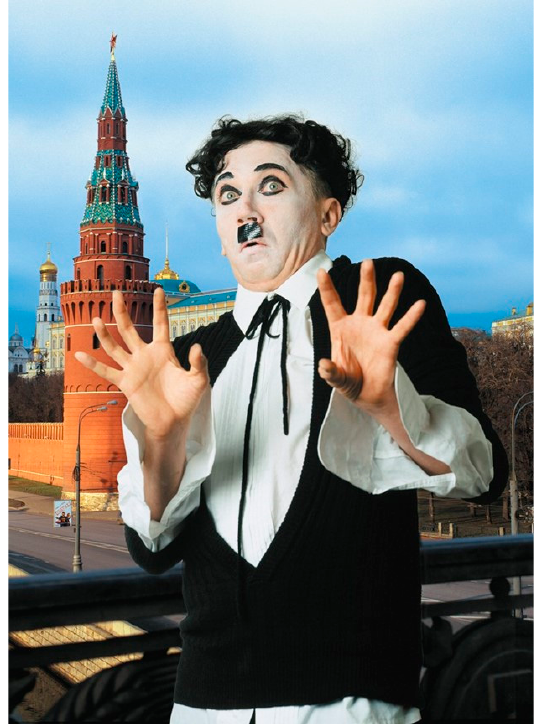
Figure 9. Vlad Mamyshev-Monroe. From the series “Star3” (2005), https://vmmf.org/series/view?id=3#work-series-3-12 (accessed on 11 September 2022).